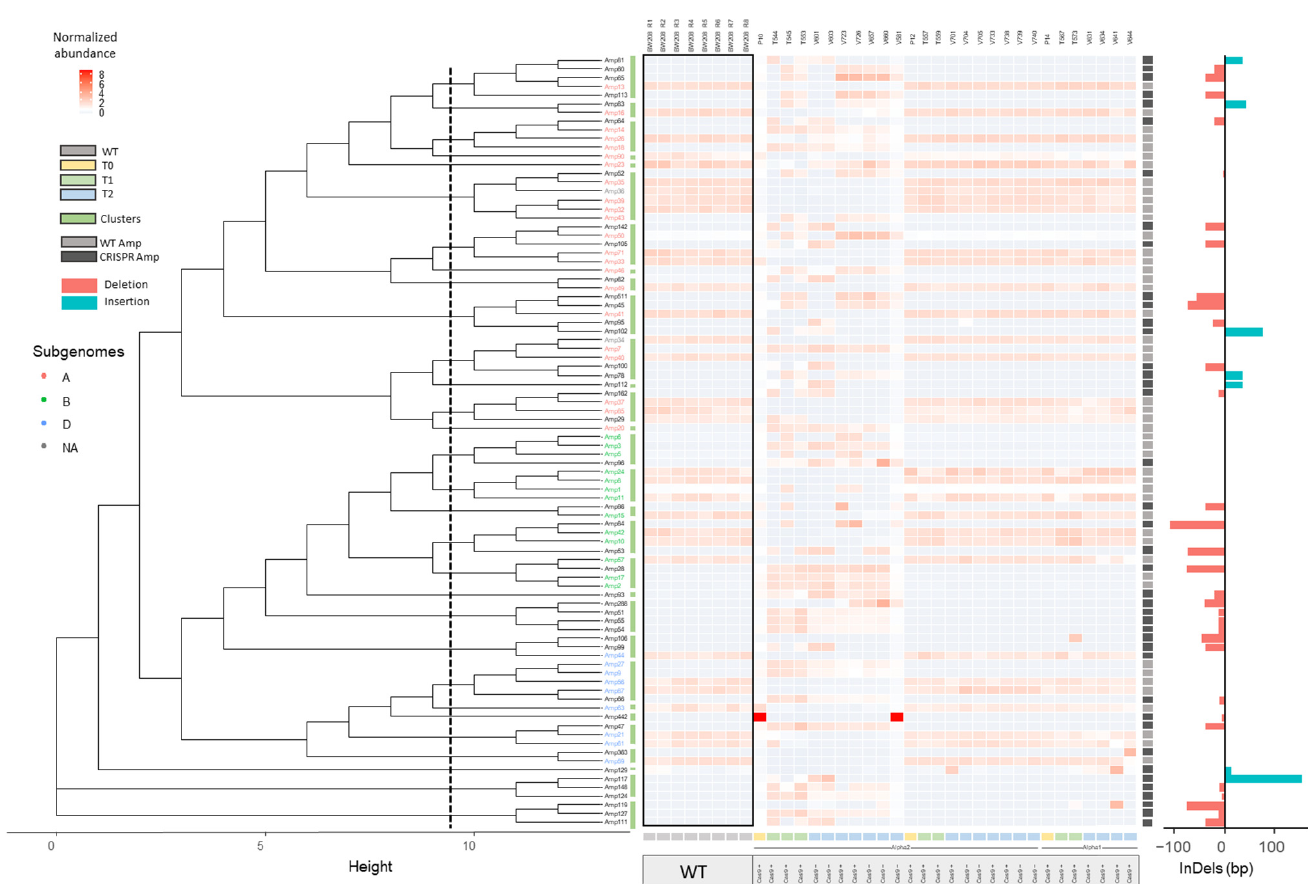
Figure 2. Dendrogram of Amps presented in lines with BW208 background, and their TMM normalized abundances represented as a min-max scaling heatmap. CRISPR Amps (only present in CRISPR lines) are represented in dark grey squares while WT Amps are represented as light grey squares. Clusters of Amps (green bars) were established according to the dendrogram ( left ) and were aligned through MUSCLE manually to detect the InDels size in CRISPR Amps ( right ). Relationship between lines (T0, T1, T2) and the absence or presence of Cas9 is also depicted per each line. Only Amps present in at least one line with a frequency higher than 0.3% per line were considered for the analysis. WT: wild type. Amps: unique denoised amplicons. NA: Amps not assigned to a subgenome.